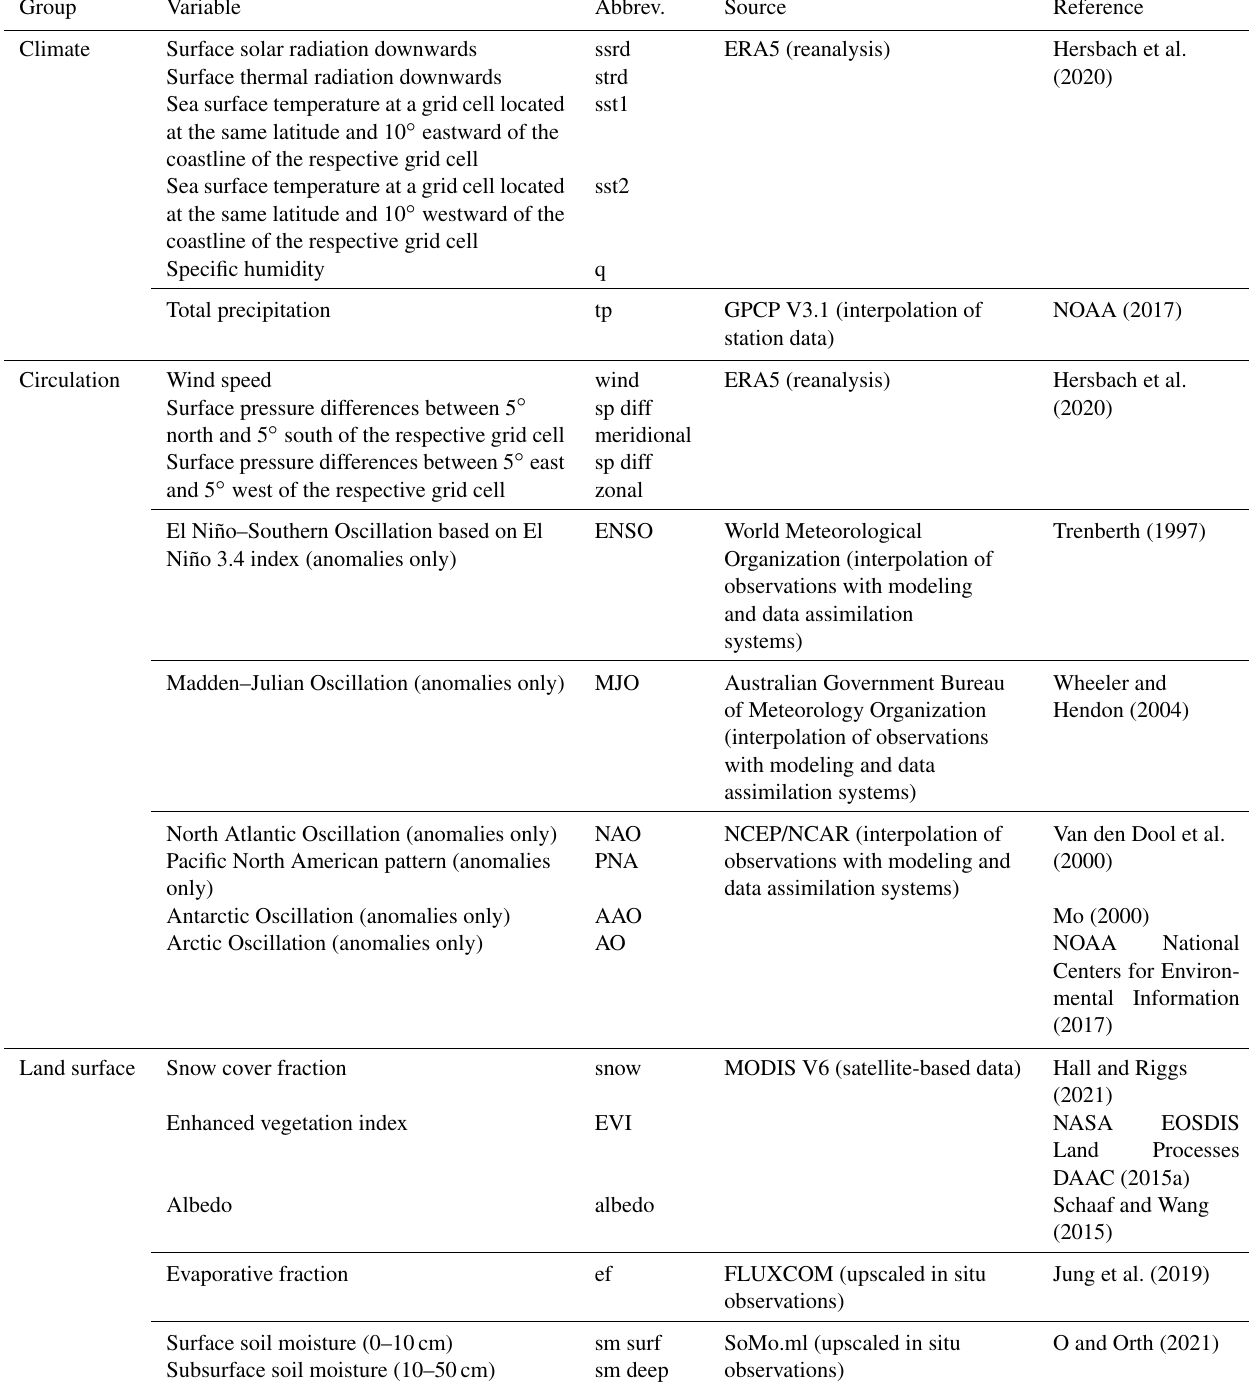
Table 1. Earth system data